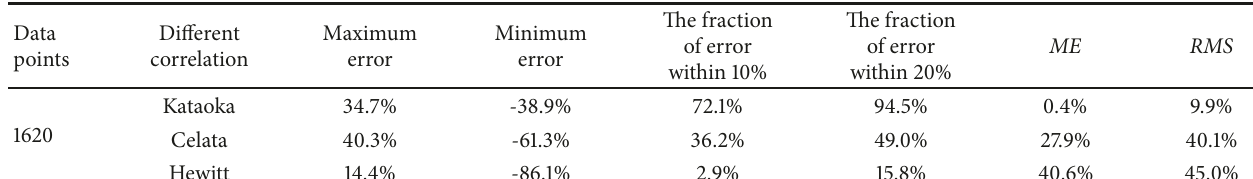
Table 6: Prediction results of three different entrainment and deposition correlations.